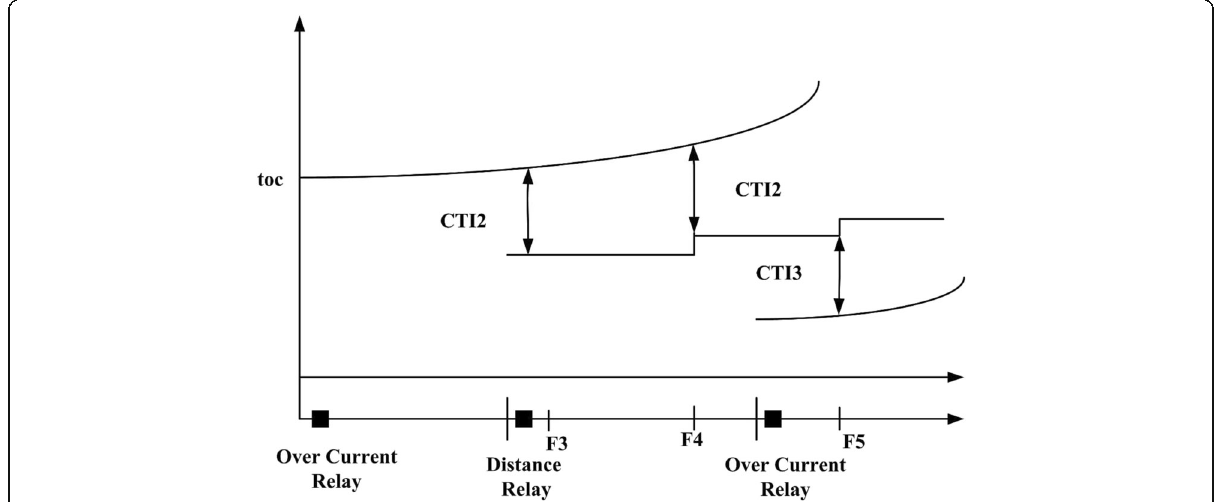
Fig. 3 Distance to over current relay